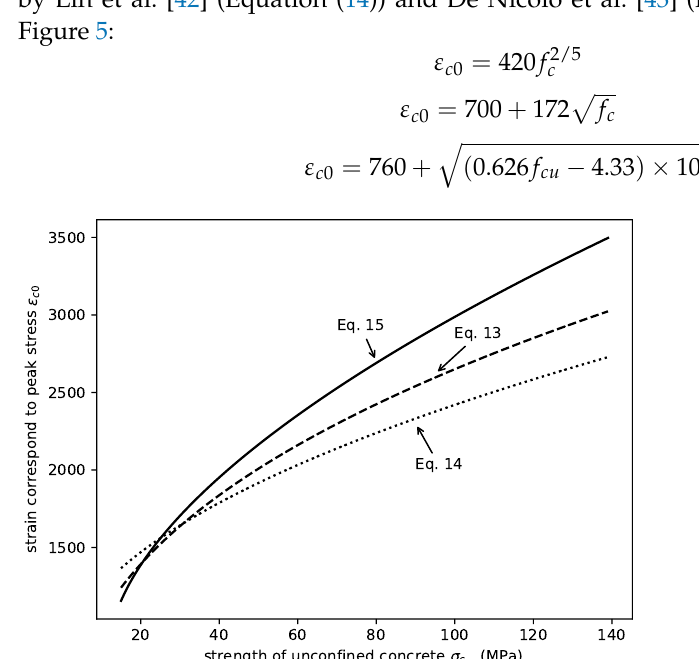
Figure 5. Comparison of ε c 0 using different